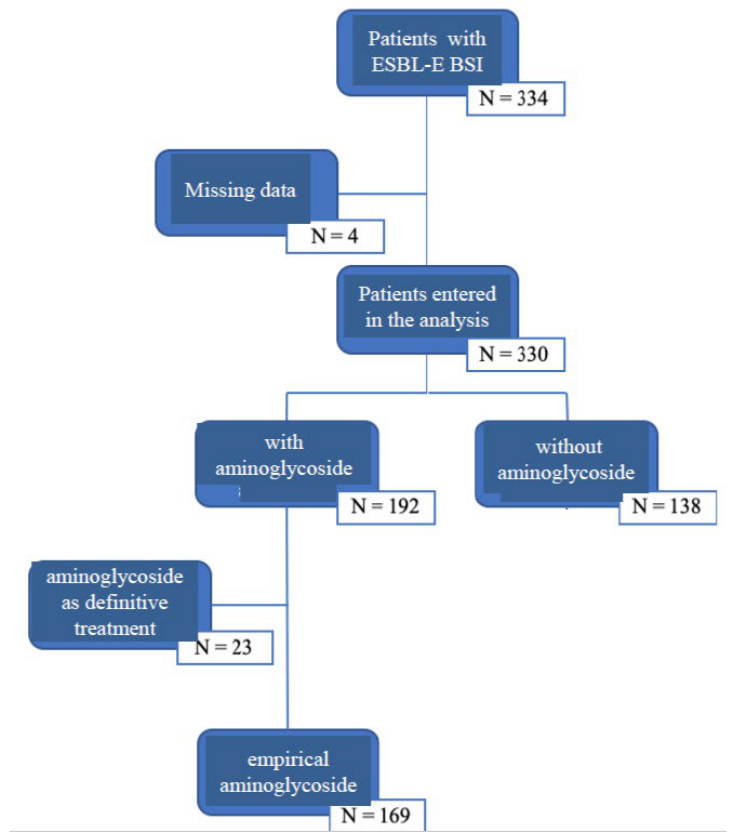
Figure 1. Flow chart of the study inclusion process.